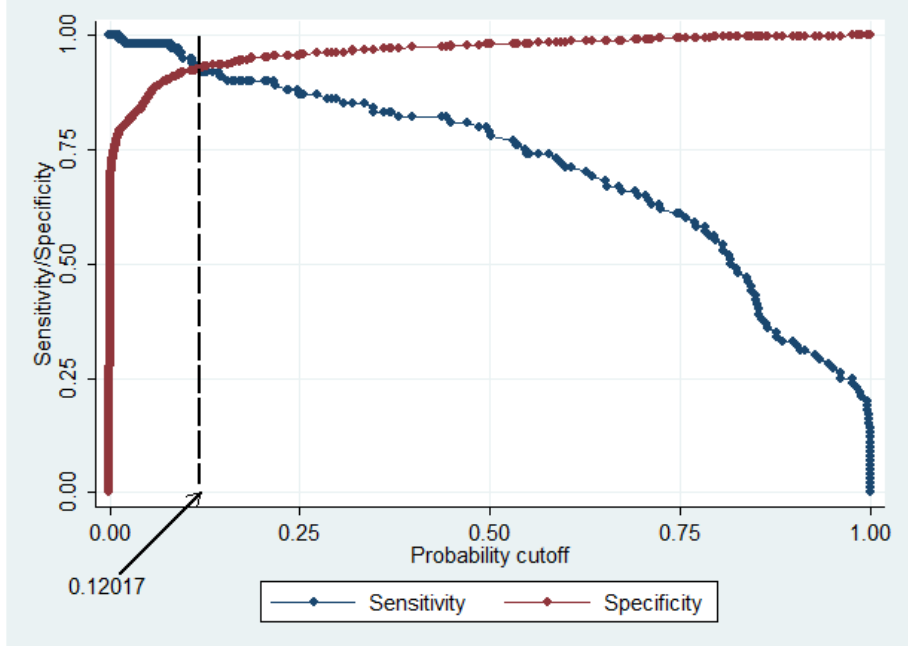
Figure 5. Optimal cut-off threshold of the 12-month EWS model in Latin America.